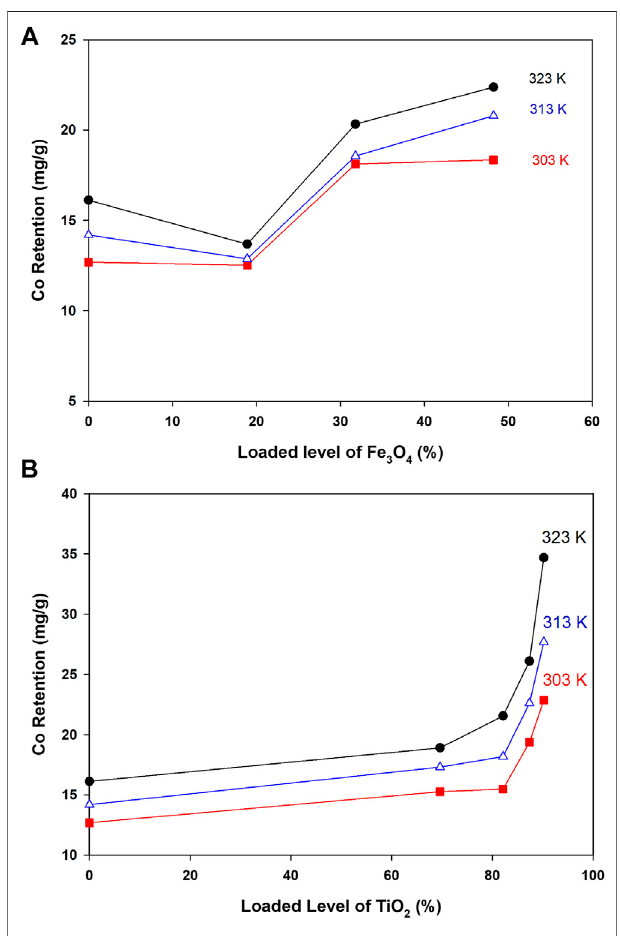
FIGURE 4 | Co retention as a function of loaded oxides and at different temperatures (Conditions: Co level 40 ppm, mass 5.0 mg, pH 6.4, and shaking time 24